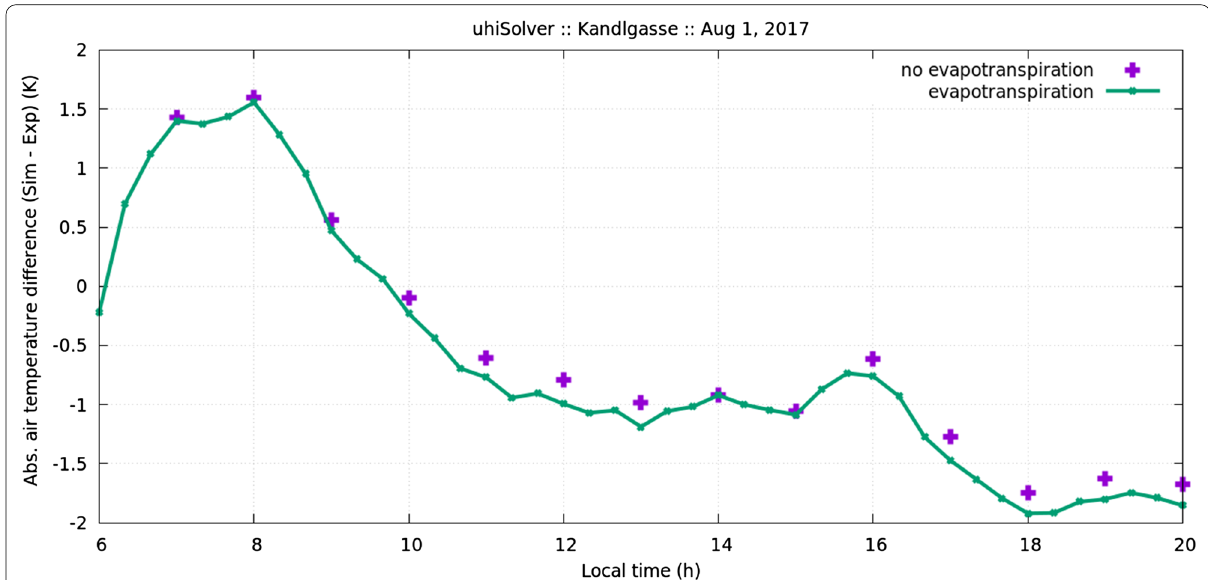
Fig. 14 Absolute error between simulation results with evapotranspiration (green line) and measurement data (violet crosses) for the validation case Kandlgasse